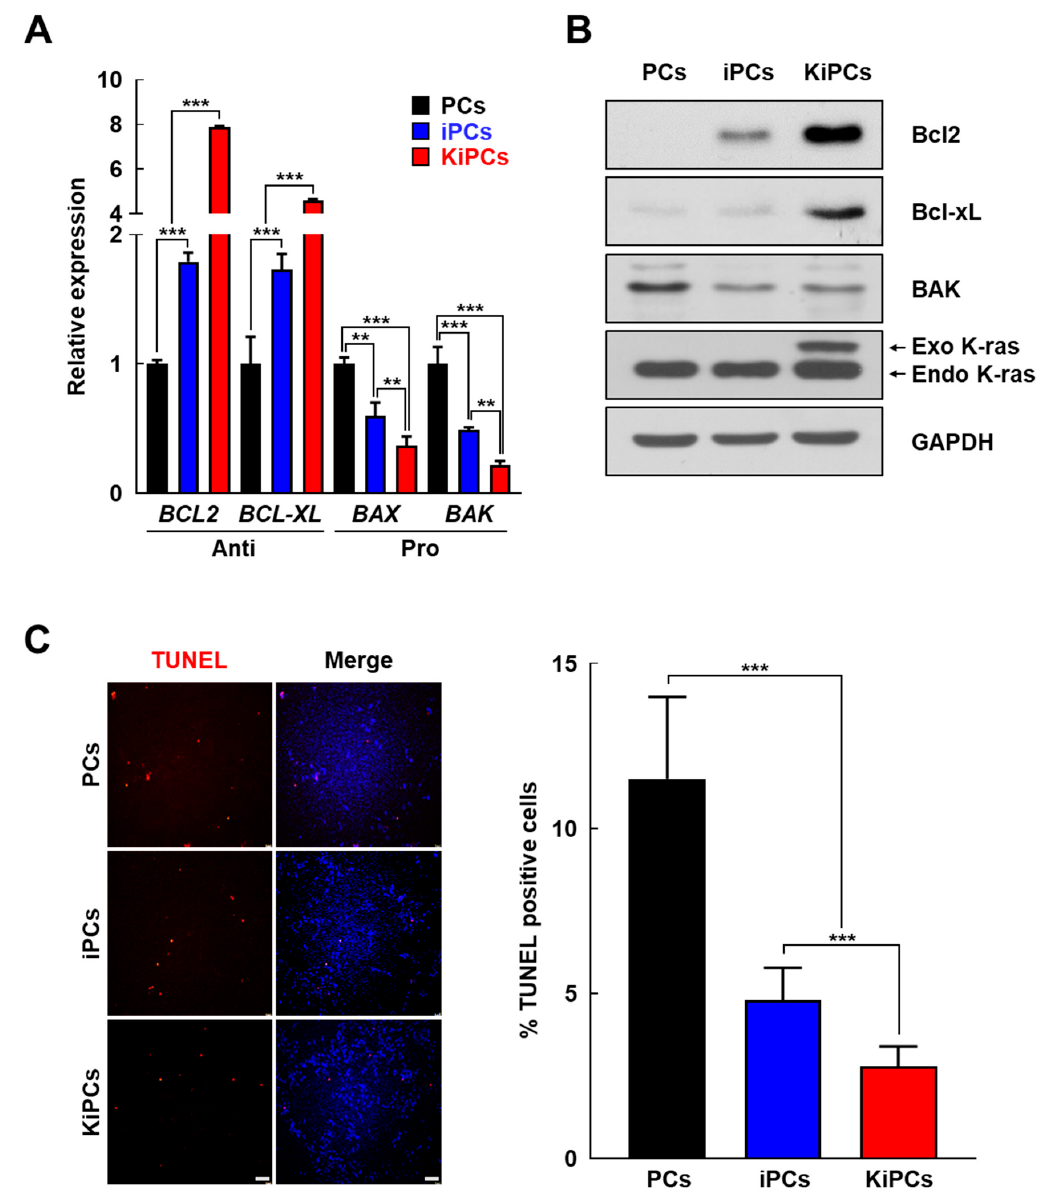
Figure 4. KiPCs exhibited reduced levels of apoptotic genes and Terminal deoxynucleotidyl transferase dUTP nick end labeling (TUNEL)-positive cells. ( A ) qPCR analysis of anti- and pro- apoptotic genes. ( B ) Anti- and pro- apoptotic proteins were measured by Western blot analysis. ( C ) Representative image of TUNEL assay for apoptosis (left) and the percentages of TUNEL-positive cells in the indicated groups (right). Magnification 100×. All experiments were performed using at least three replicates, and the results are representative of three independent experiments. Data are presented as means ± standard deviation. ** p < 0.01, *** p < 0.001, one-way analysis of variance with